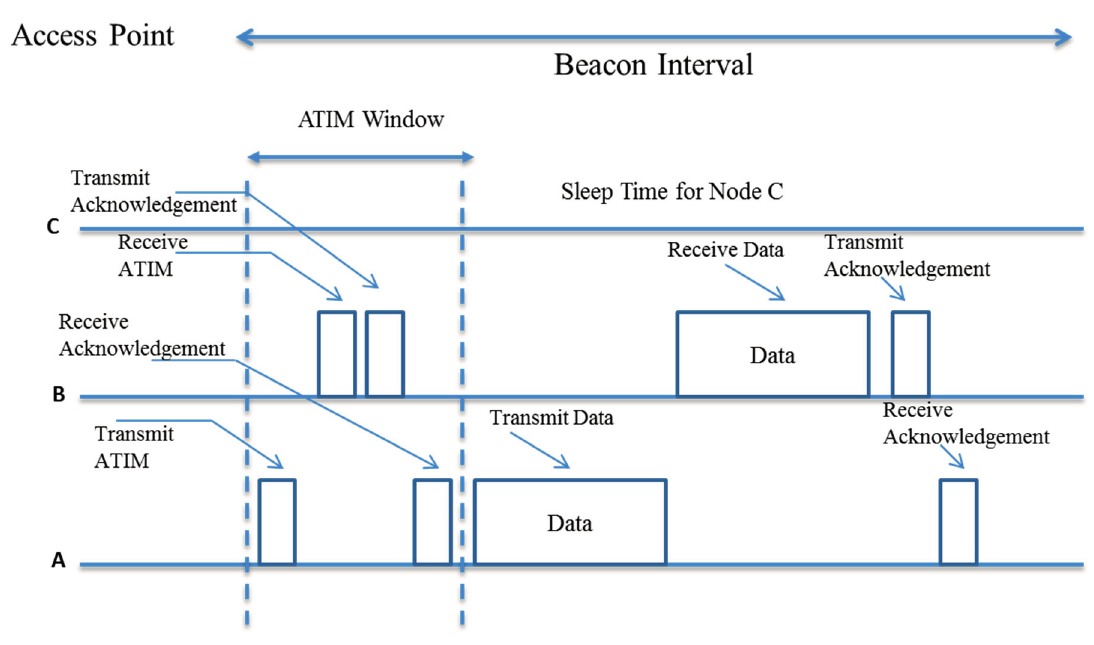
Figure 5. An illustration of IEEE 802.11